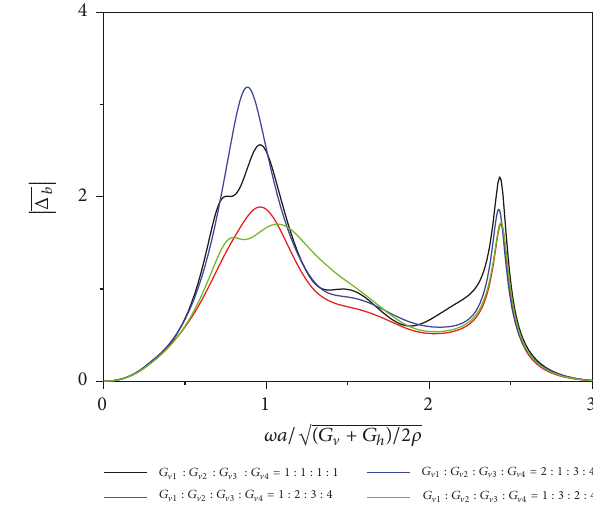
Figure 9: The superstructure response in multiple TI soil layers ( 𝜀 = 2 , 𝑀 /𝑀 = 1 𝑏 0